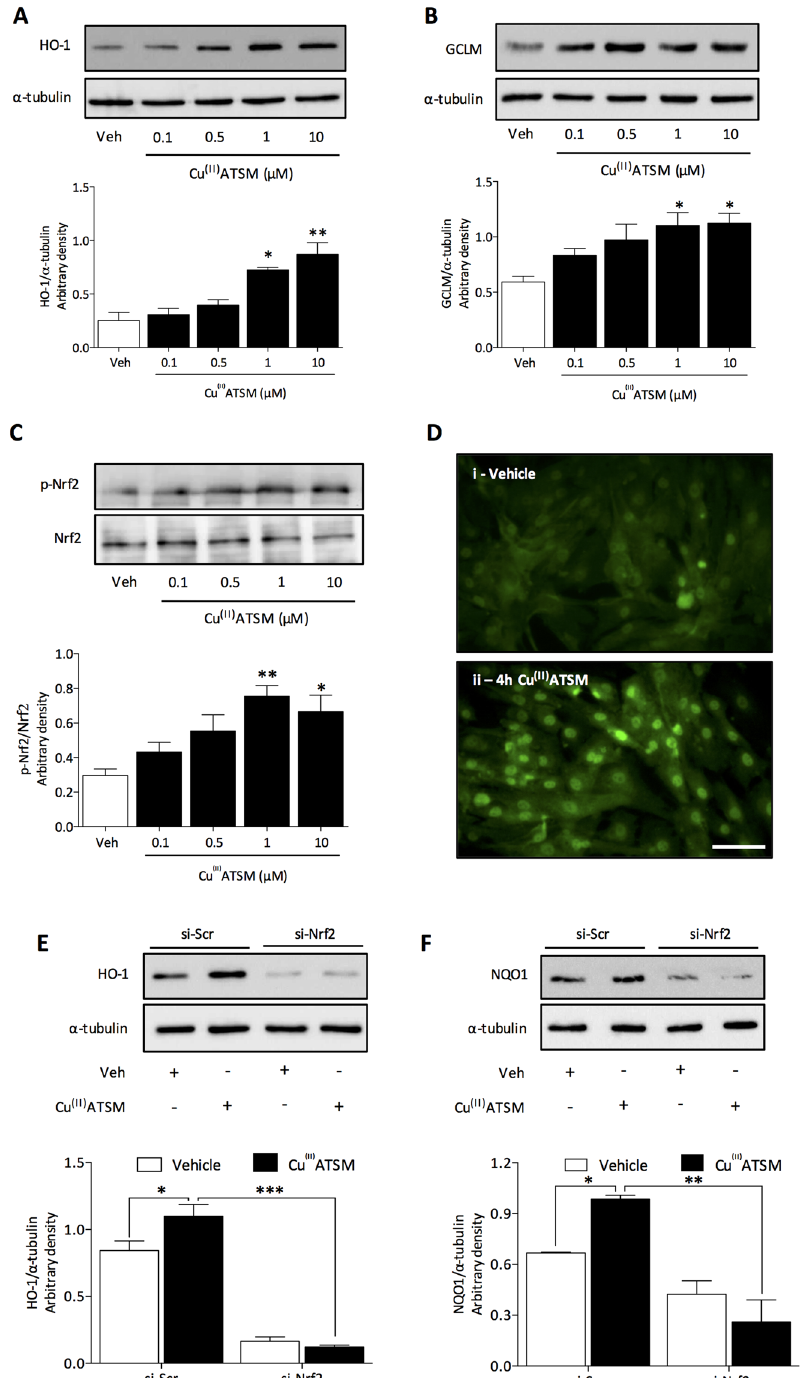
Figure 1. Cu (II) ATSM induces nuclear translocation of Nrf2 and antioxidant protein expression in HCASMC. HCASMC were treated with Cu (II) ATSM (0.1, 0.5, 1 and 10 µ M) for 12 h and expression of ( A ) HO-1 and ( B ) GCLM assessed by immunoblotting with densitometric analysis relative to α -tubulin. Data denote mean ± S.E.M., n = 5, * P < 0.05, ** P < 0.001 vs vehicle (one-way ANOVA and Bonferroni post hoc analysis). ( C ) HCASMC were treated with Cu (II) ATSM (0.1, 0.5, 1 and 10 µ M, 30 min) and phosphorylation of Nrf2 at serine 40 assessed by immunoblotting with densitometric analysis relative to total Nrf2. Data denote mean ± S.E.M., n = 4, * P < 0.05, ** P < 0.001 vs vehicle (one-way ANOVA and Bonferroni post hoc analysis). ( D ) HCASMC were treated with Cu (II) ATSM (1 µ M, 4 h) and Nrf2 localisation assessed by fluorescence microscopy (scale bar = 5 µ m). Induction of ( E ) HO-1 and ( F ) NQO1 protein in response to Cu (II) ATSM (1 µ M, 12 h) was assessed following transient transfection of cells with scramble (Scr) si-RNA or Nrf2 siRNA. Data denote mean ± S.E.M., n = 4, * P < 0.05, *** P < 0.001 (two-way ANOVA and Bonferroni post hoc